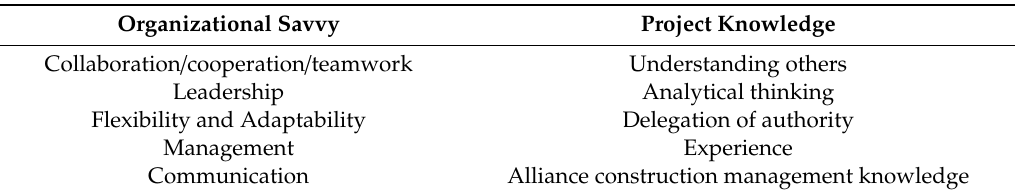
Table 9. Project managers’ competencies in collaborative construction projects, identified from interviews.